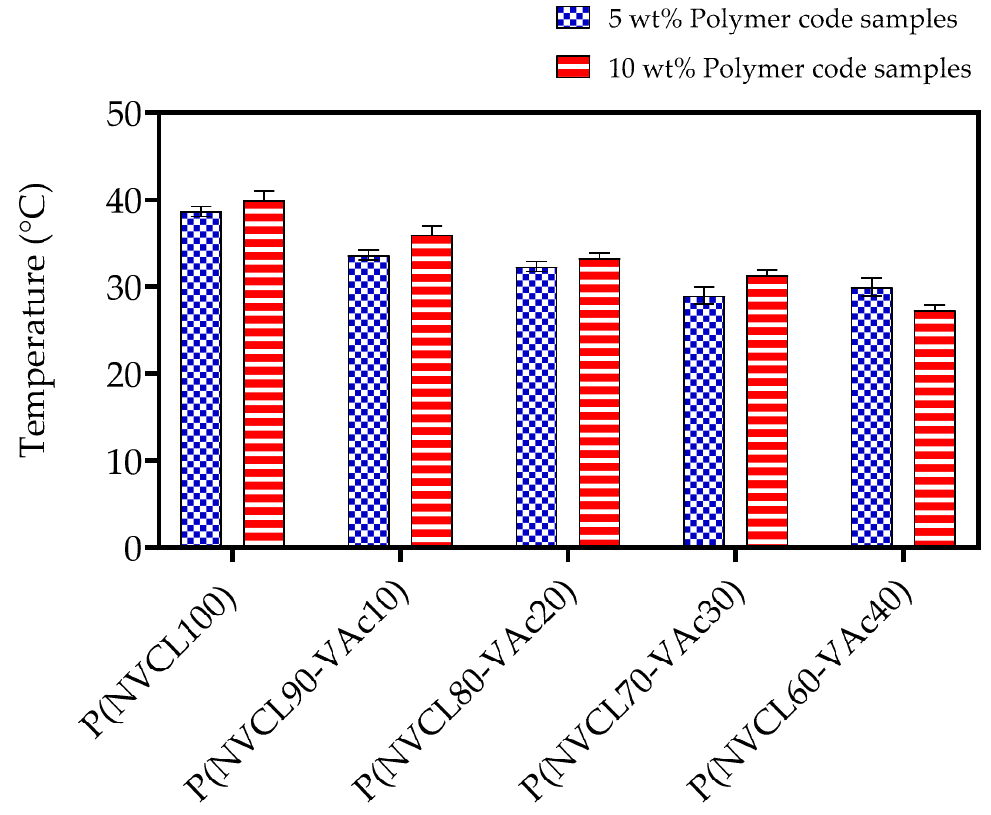
Figure 8. Gelation determination of PNVCL with VAc polymers for both 5 wt% and 10 wt% samples.